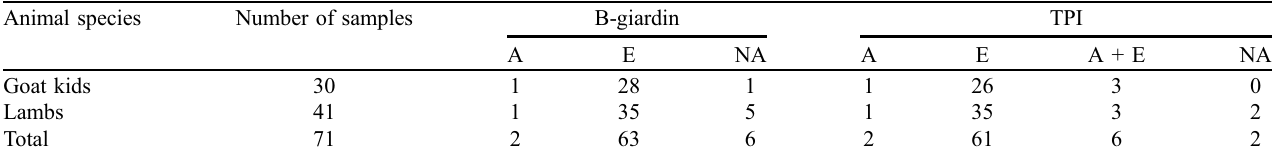
Table 2. Results for molecular identification of Giardia duodenalis positive samples in goat kids and lambs, based on the B-giardin (= beta- giardin) or triose phosphate isomerase (TPI) gene (NA = no amplification; A = assemblage A; E = assemblage E; A + E = mixed infection with assemblage A and